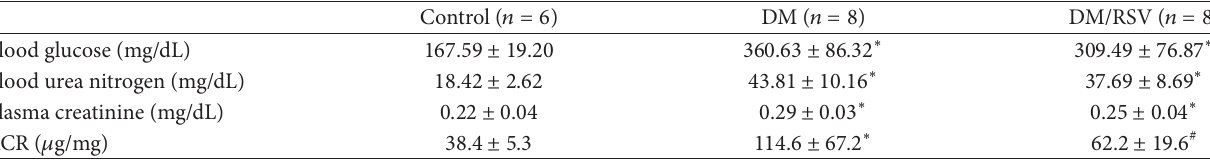
Table 1: The effects of RSV on biochemical parameters in diabetes